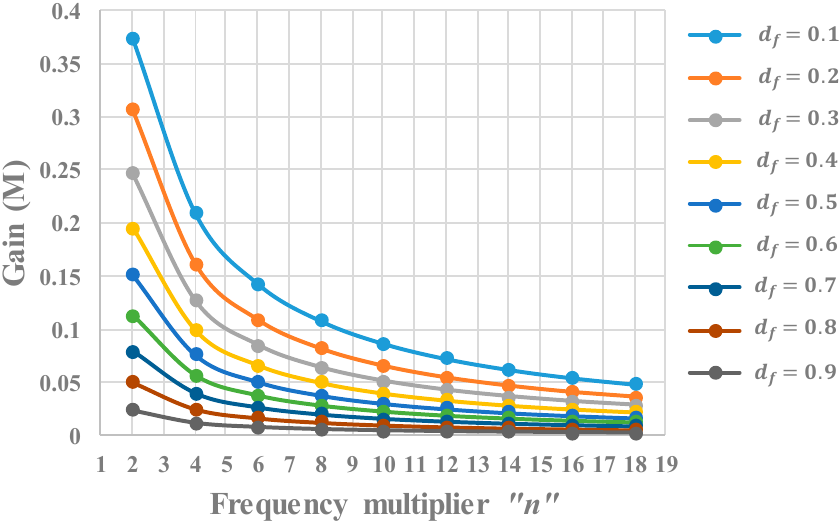
Figure 6. Gain (M) with even values of “ n ” and fixed damping factor “ d f ”.